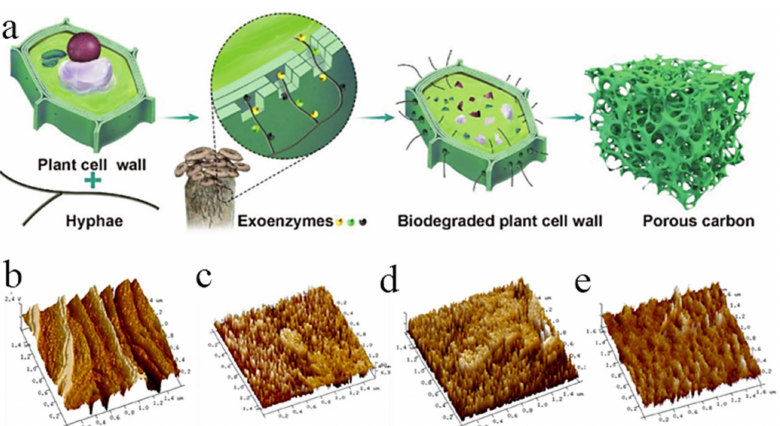
Figure 10. ( a ) Mechanism of pore structure regulation of plant materials by fungi [99]; ( b – e ) AFM images of lotus leaves after fungal treatment